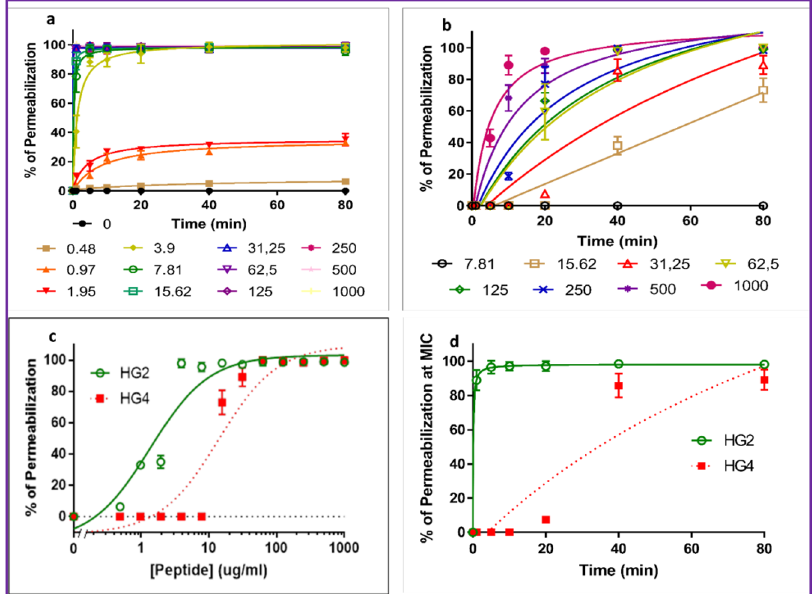
Fig. 4 Membrane permeabilisation action of HG2 and HG4 against MRSA USA300 cells. a Membrane permeabilisation activity of HG2 at different concentrations (µg/ml) against MRSA USA300 cells measured by propidium iodide assay over time. b Membrane permeabilisation activity of HG4 at different concentrations (µg/ml) against MRSA USA300 cells measured by propidium iodide assay over time. c Determination of EC50 (effective concentration 50) of HG2 and HG4 membrane permeabilisation measured after 80 min. d Membrane permeabilisation kinetics of HG2 and HG4 at their MIC concentration. In all cases, values are from three independent replicates; results are expressed as means ± standard